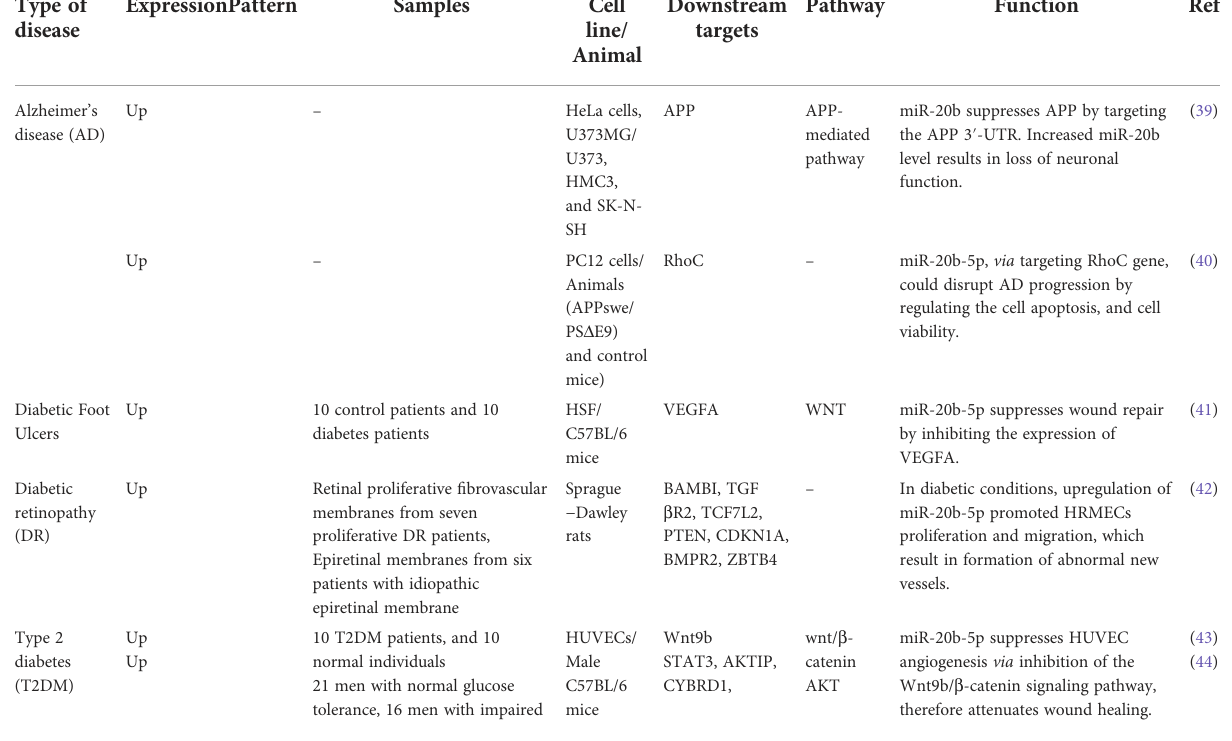
FIGURE 6 miR-20b-5p dependent and independent regulation of E2F1 levels and G1/S transition. The pathways I, II, and III as miRNA- dependent, and IV as miRNA-independent methods are proposed to modulate E2F1 levels under oxidative stress. In the pathways I and II, the lower expression of miRNAs leads to an increase in the p21 expression, and CCND1/2 and CDK4/6, respectively. In the pathway II, miRNA and E2F1 have an auto-regulatory feedback effect on each other. Finally, in the pathway IV, E2F1 is recruited to DNA break sites as a result of oxidative stress causing DNA damage responses. Overall, E2F1 is downregulated, the G1/S transition and DNA synthesis are inhibited, cell proliferation is repressed, leading to cell senescence. The proposed scheme is more fully described in the text.